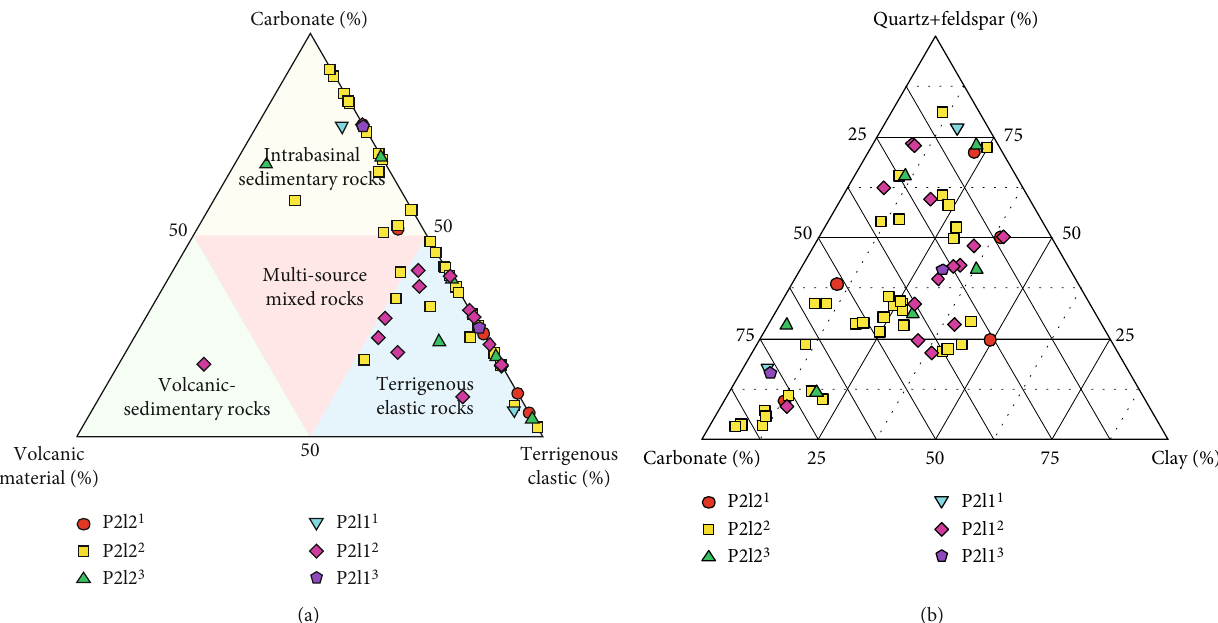
Figure 3: Classi fi cation system of rocks in the Lucaogou Formation, Jimusar Sag. (a) Ternary diagram of carbonate, volcanic, and terrigenous clastic material contents. (b) Ternary diagram of carbonate, clay, and felsic mineral